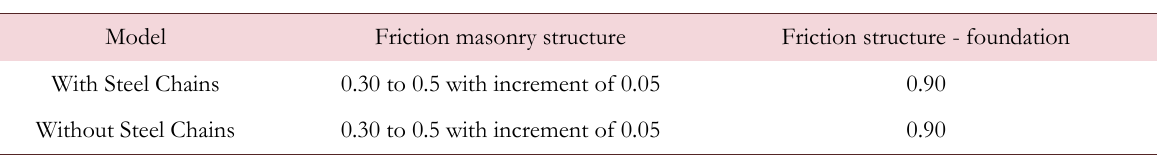
Table 1: Different friction values used for the dynamic nonlinear analyses